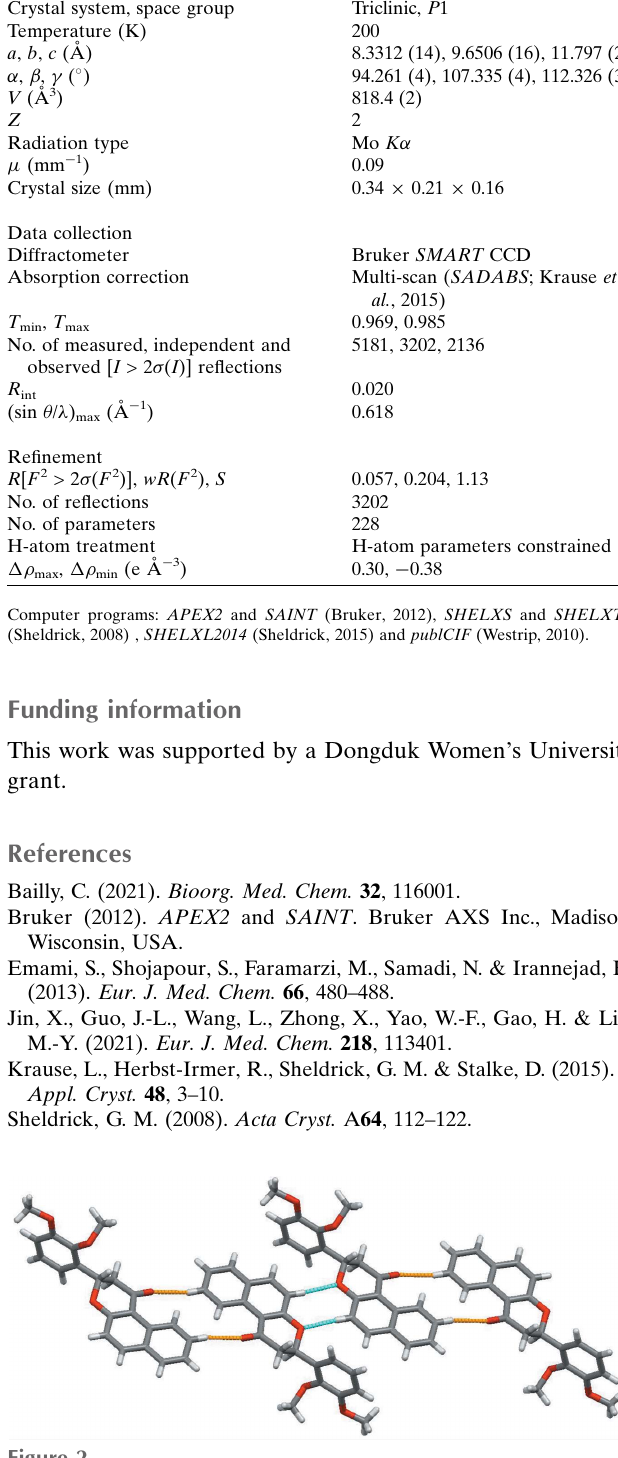
Crystal data Chemical formula